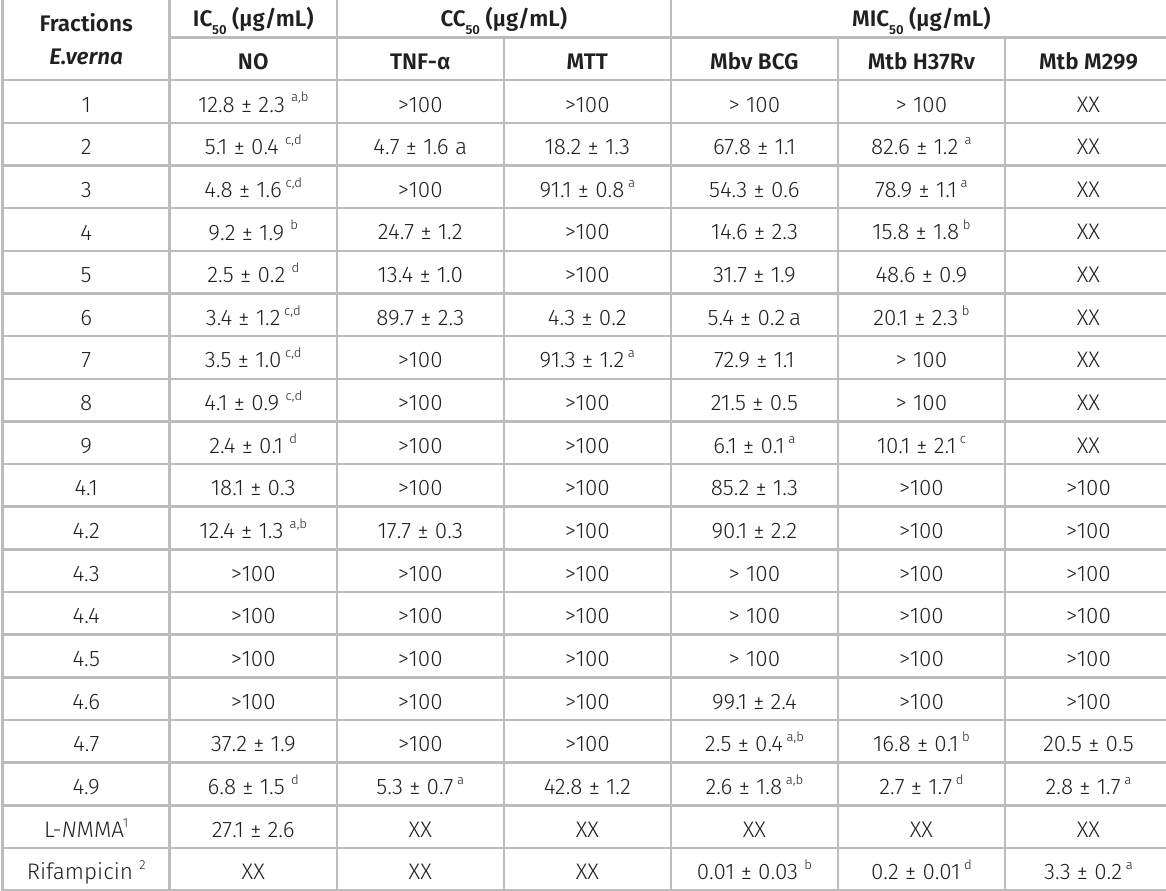
Table I. Inhibitory effects of Erythrina verna fractions on production of NO and TNF-α by LPS-stimulated RAW 264.7 macrophages, on growth of M. bovis BCG, M. tuberculosis H37Rv and clinical isolate M. tuberculosis M299 in culture and evaluation of cytotoxicity by MTT